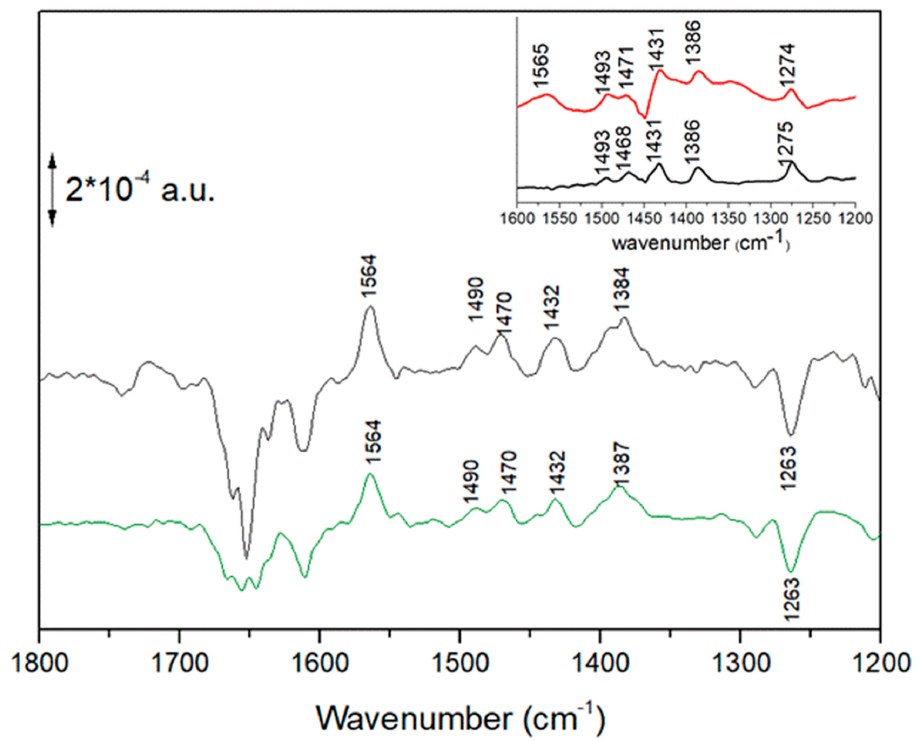
Figure 6. Upper trace, black: FTIR difference spectrum recorded on chromatophores between 1302 and 1736 ms after a 4.3 s period of intense illumination (see also Figure 3). Lower trace (green): calculated FTIR spectrum in detergent-isolated RCs after two saturation flashes (see also Figure 5). Inset: spectra of synthetic Q 6 H 2 in cyclohexane in freshly prepared solution (black trace) and after exposure of the solution to air for some hours (red